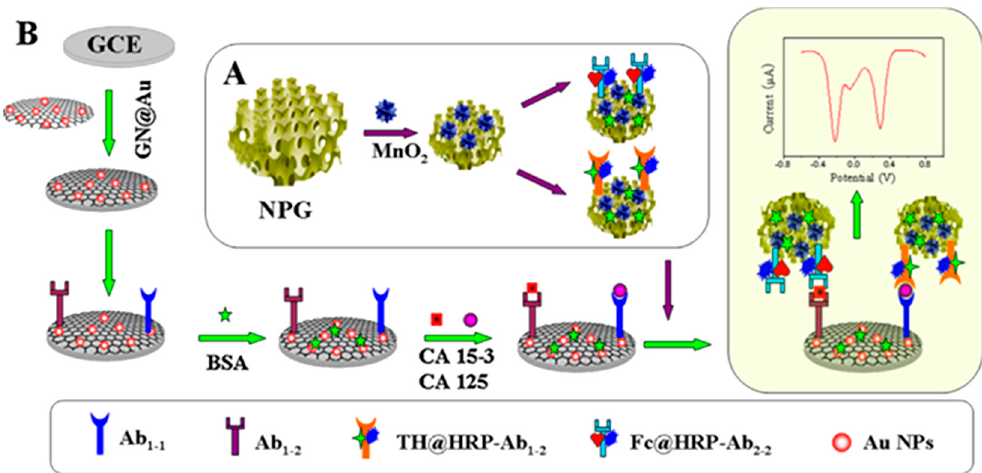
Figure 6. Schematic illustration of the fabrication procedure of the immunosensor developed for CA15-3 and CA125 using NPG-MnO2 and THI or Fc as the redox probes. ( A ) Functionalization of NPG with cactus-like MnO2; ( B ) Steps involved in the preparation of the immunosensor. Reprinted from Ref. [37] with permission.